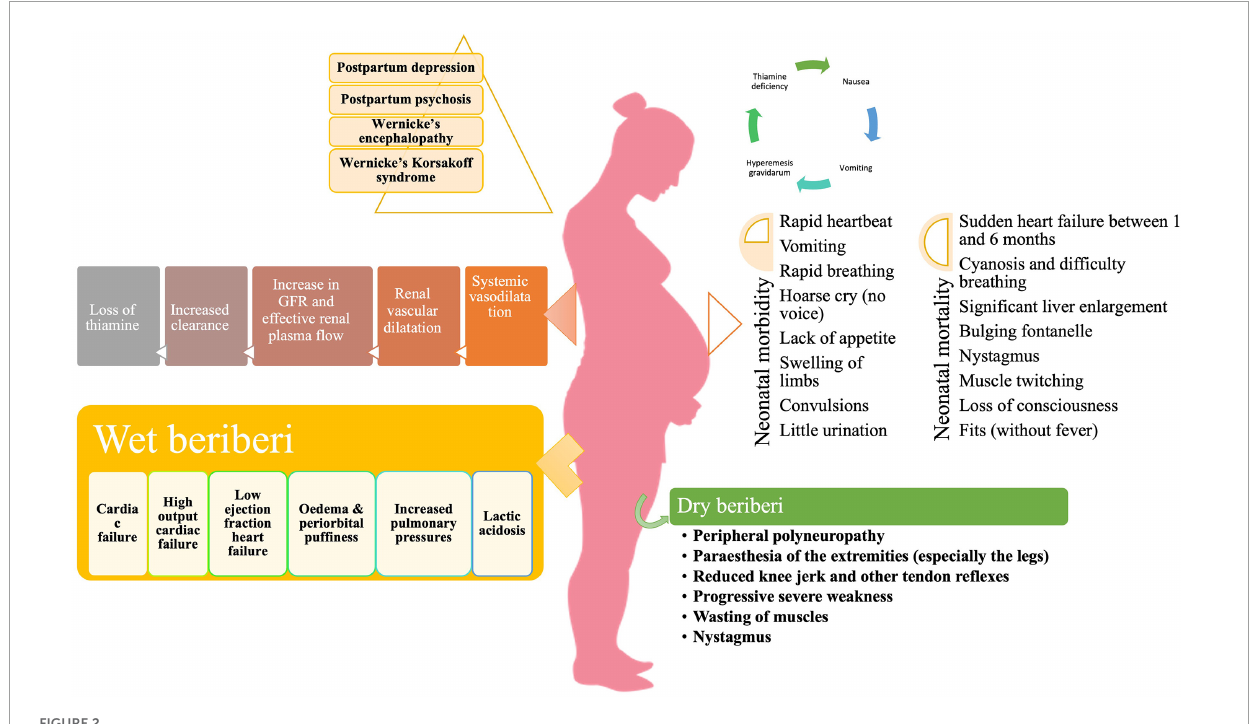
FIGURE2 Clinical consequences of thiamine deficiency in